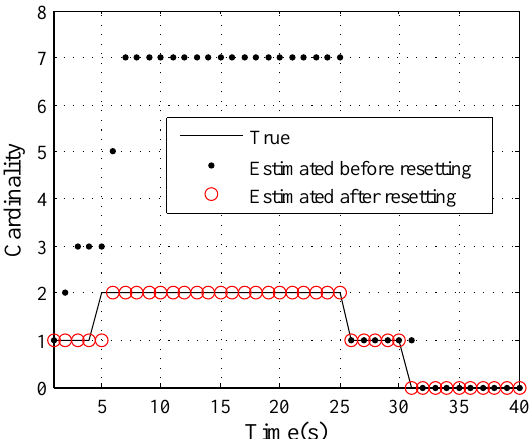
Figure 5. The true cardinality and the estimated cardinality before and after applying the proposed